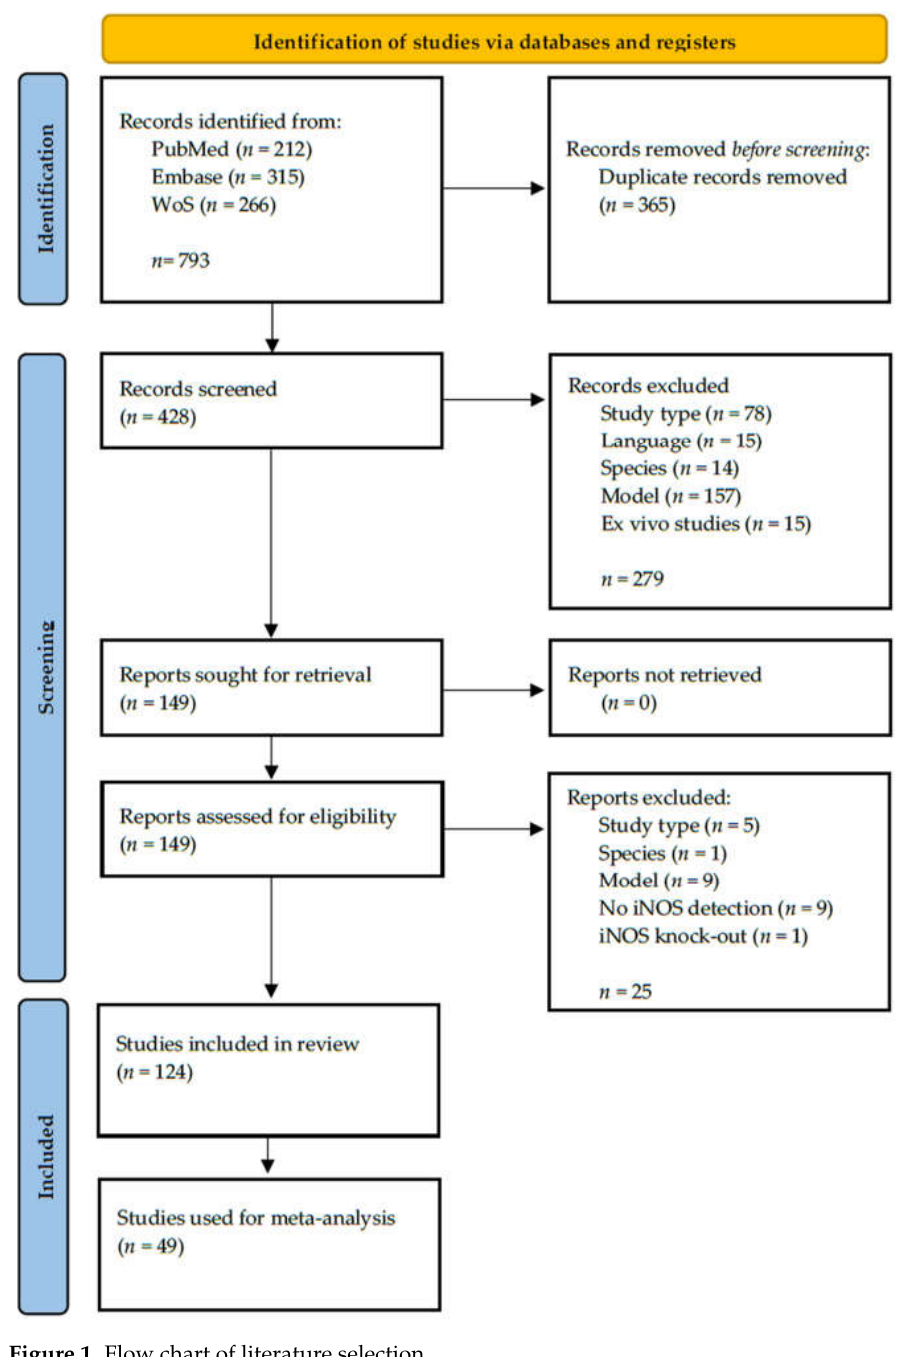
Figure 1. Flow chart of literature selection.